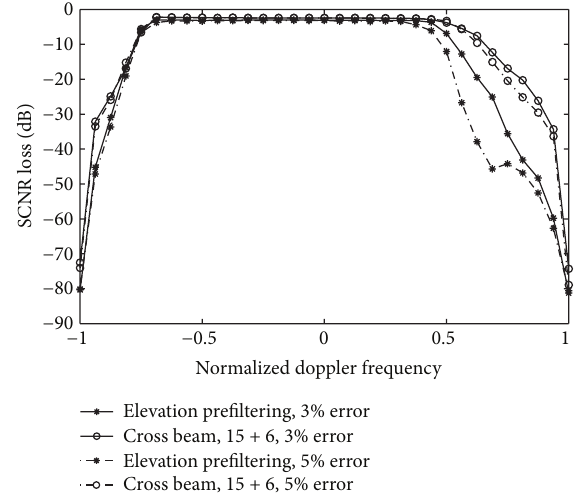
Figure 6: Eigenspectrum of clutter at the 28th Doppler bin.